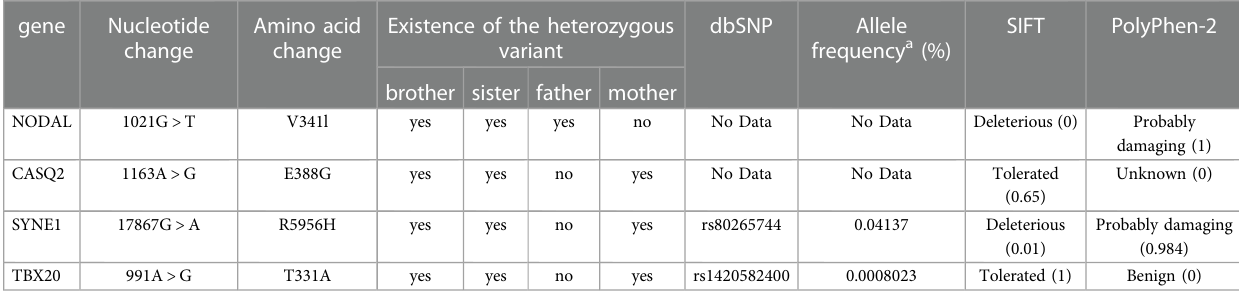
TABLE 1 Detected variants from the siblings with